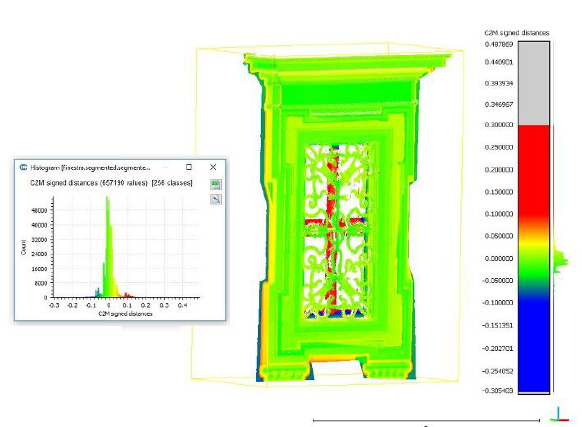
Figure 3: The deviation analysis of a window of St. Basilio monastery in L’Aquila (19th century) for the Level of Accuracy (LoA) evaluation.